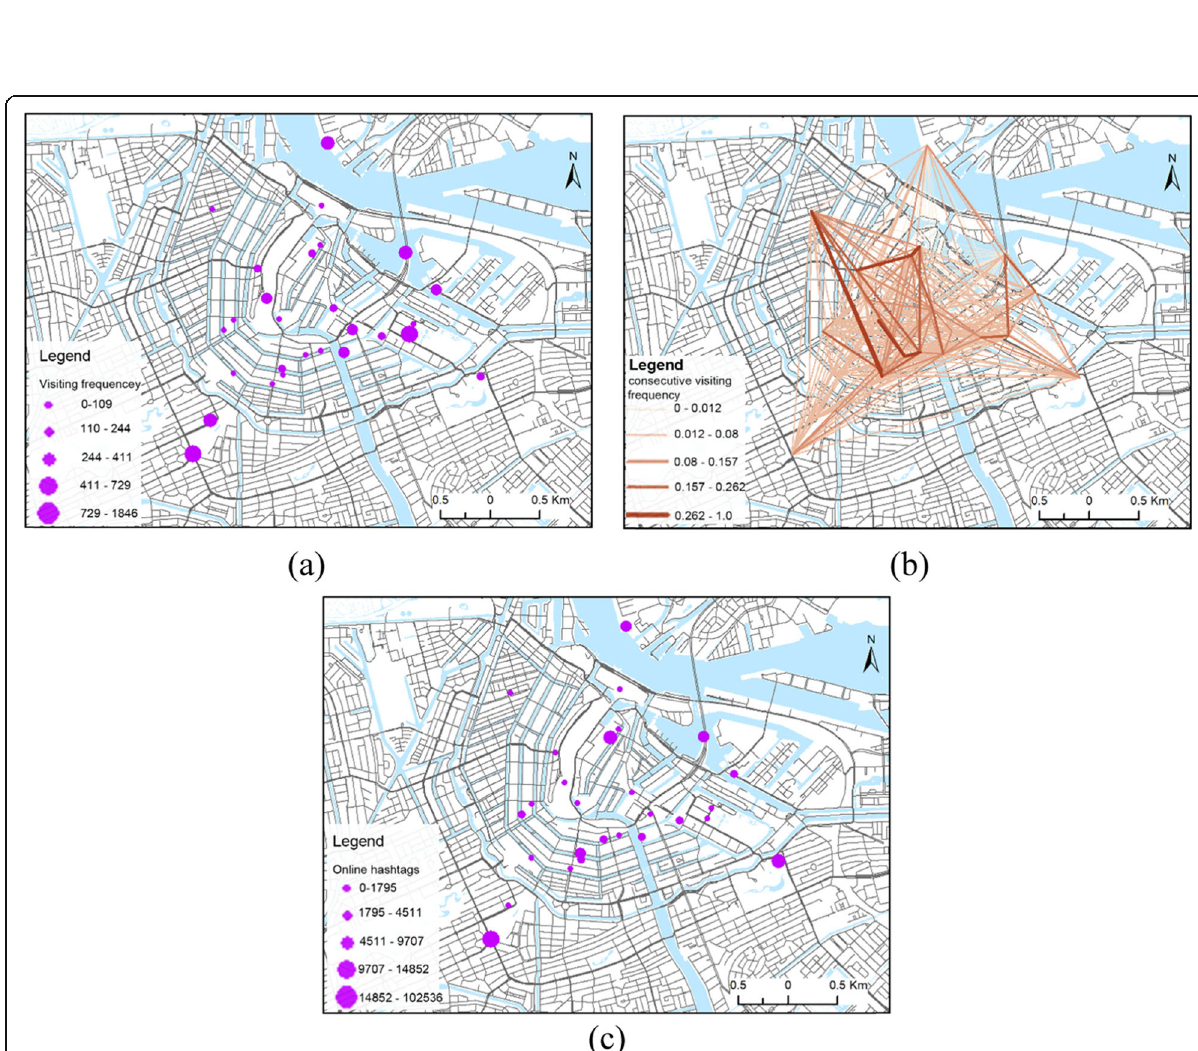
Fig. 4 Characteristics of museums in Amsterdam ’ s Central area. a Offline popularity of museums. b Visitation frequency of a pair of museums; c online presence of